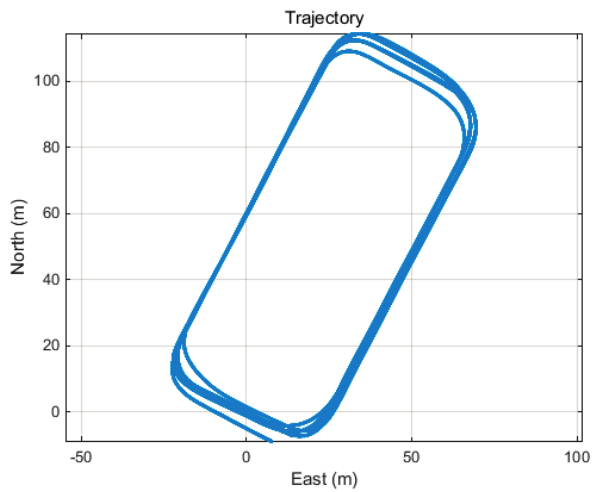
Figure 12. Experimental trajectory.